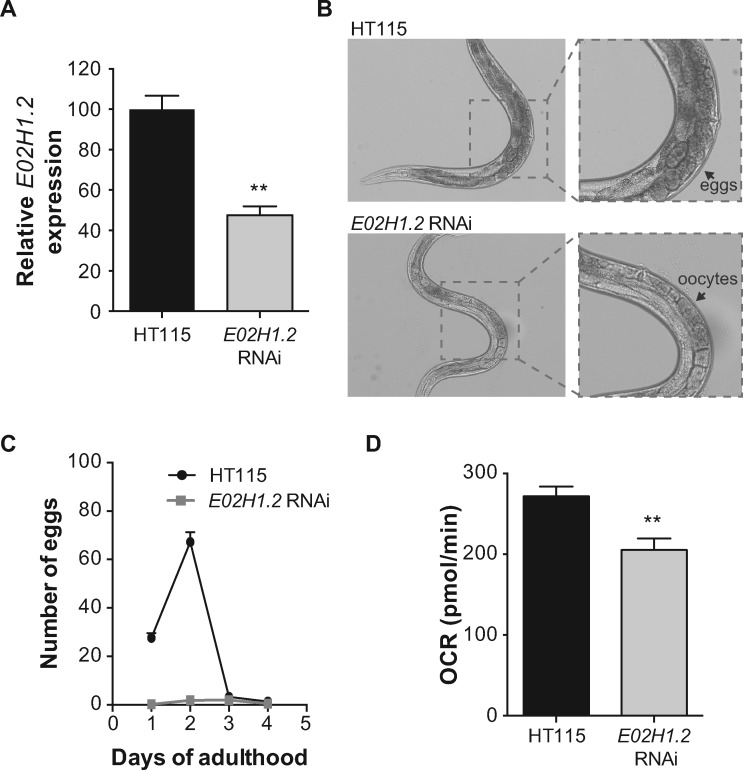
Knockdown of the ERAL1 worm homologue E02H1.2
compromises fecundity and reduces respiration in C. elegans.
(A) mRNA levels of knockdown efficiency of E02H1.2 in
worms fed with control HT115 and E02H1.2 RNAi as measured by qPCR. Worms fed with
E02H1.2 RNAi present with 50% reduction of E02H1.2 gene expression.
Data are represented as the mean±SEM of biological triplicates. **p<0.01 as
calculated by a 2-tailed student’s t-test. (B) Wide-field images of adult
(day 1) worms fed with control HT115 (upper panels) and E02H1.2 (lower panels) RNAi;
worms with E02H1.2 knockdown do not carry any eggs, in contrast to
the controls. (C) Graph showing the number of eggs laid over the first
four days of adulthood. Worms with E02H1.2 knockdown laid almost no
eggs compared to the controls. Egg-laying of 30 individual worms was followed. Error
bars correspond to SEM. (D) Basal respiration measured on worms fed with
control (HT115) or E02H1.2 (ERAL1) RNAi. Worms with
E02H1.2 knockdown have significantly (p < 0.01) decreased basal
respiration compared to the controls. n = 8. Error bars correspond to SEM.